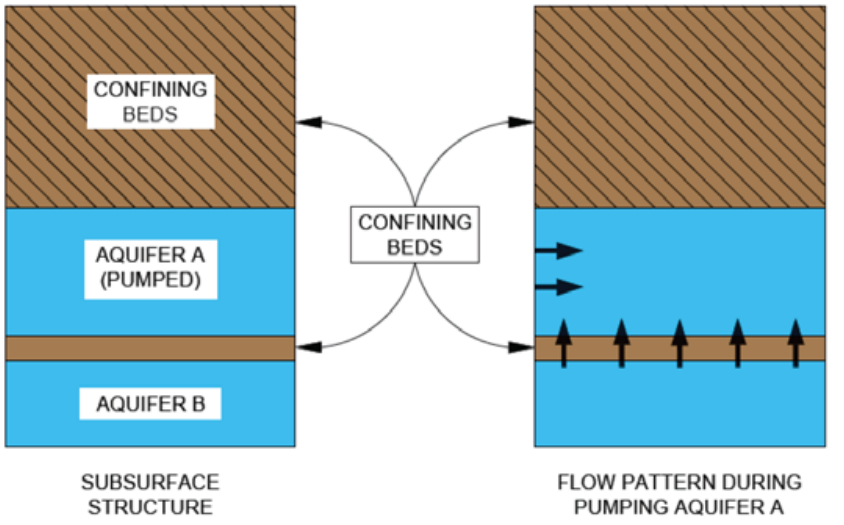
Figure 1. General conceptual model applied to wellfields being used to provide feedwater to BWRO plants in southern Florida (from Drendel et al. [20]).